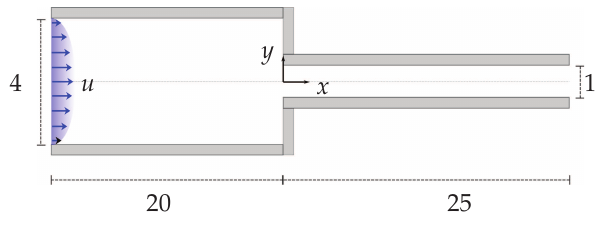
Figure 8. Domain representation. Table 6. Flow parameter values used in the contraction problem. Planar Contraction Flows